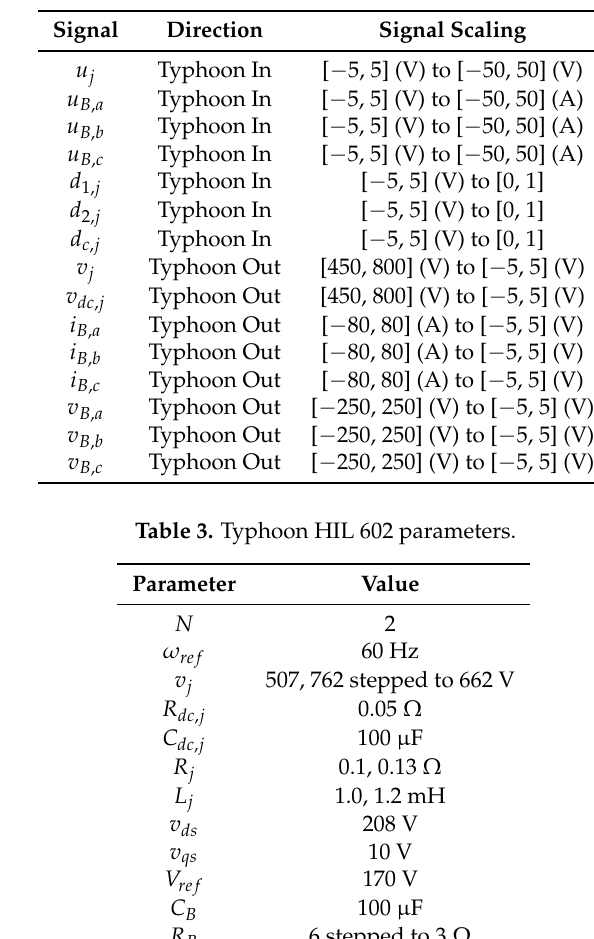
Table 2. Communication channels between the Typhoon HIL and Opal RT for a two-source inverter microgrid.